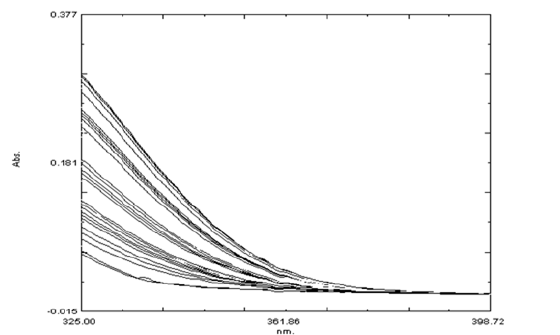
Figure 1. Electronic spectra variation of the reaction between cis- [Pt ( p -Tol)